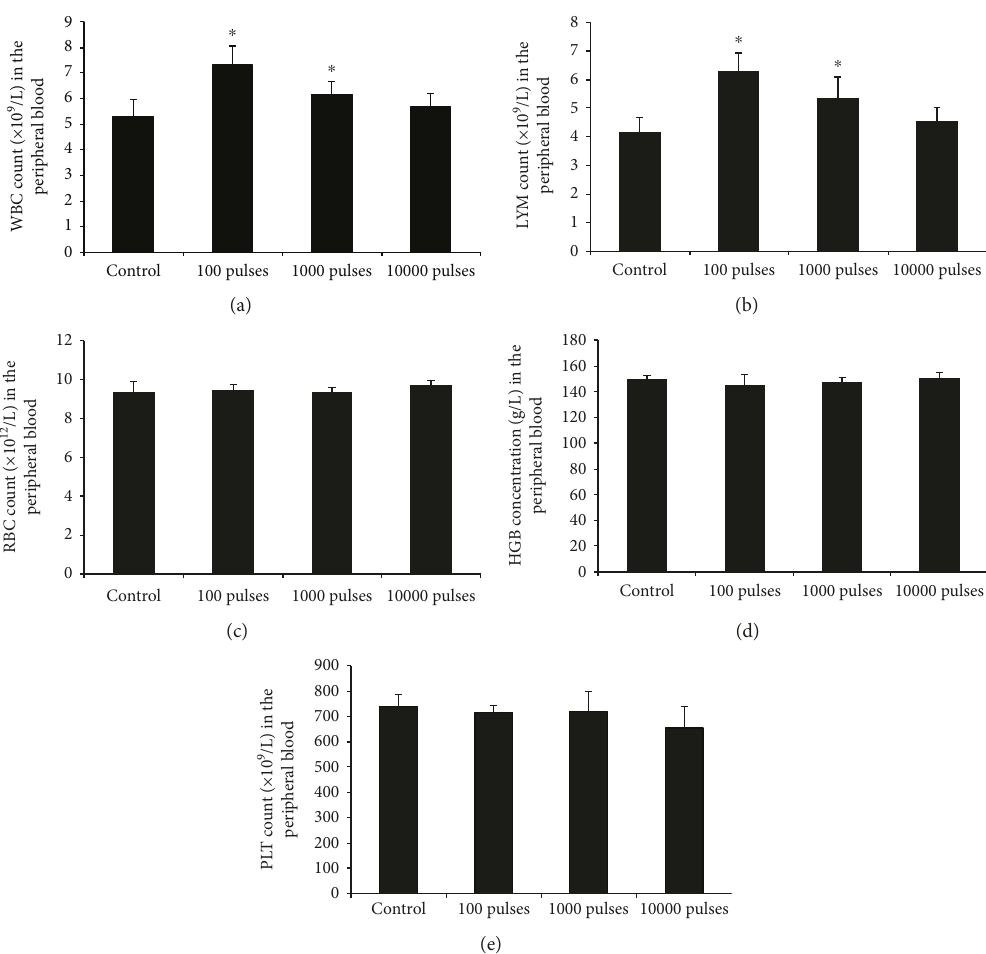
Figure 1: Changes of hematologic parameters in mice after exposed to PEMF at di ff erent pulses. Blood samples were collected and the hematologic parameters including WBC (a), LYM (b), RBC (c), HGB (d), and PLT (e) were examined. All data were presented as mean ± SD . ∗ P < 0 05 vs. control.